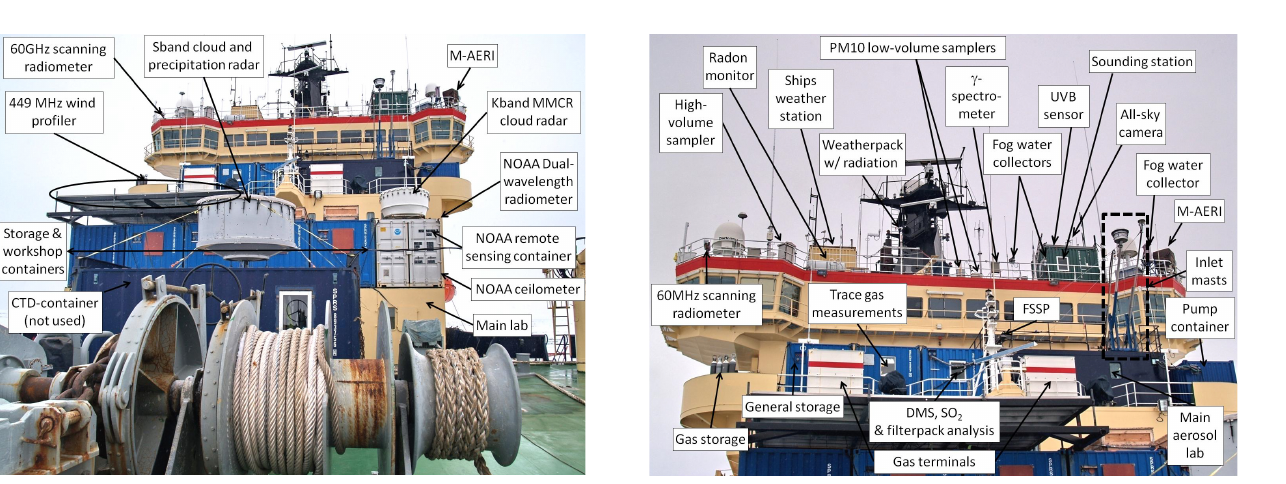
Fig. 6. Photograph of the installations on Oden ’s fourth and seventh decks. On the fourth deck the large aerosol container to the right with the sampling inlets on the roof is seen, with the two trace gas containers in the middle. To the far right is the common pump con- tainer, holding the pumps for all instruments. The two small con- tainers of the upper seventh deck hold the ship’s weather station (yellow to the left) and the sounding station (green to the right), both also holding electronics and computers for many of the other instruments. The scanning microwave radiometer is on the far left, the secondary weather station in the middle, and the M-AERI on the far right. Lined up along the front railing are a multitude of aerosol and fog water sampling instruments, and the radon